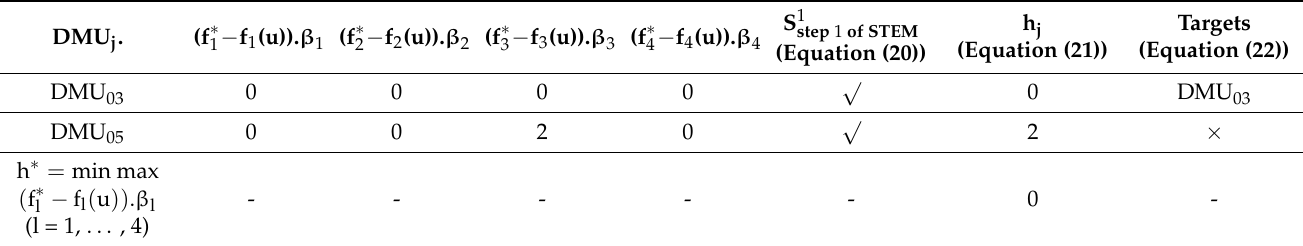
Table 11. Applying target finding stages 1–2 to solve step 1 of STEM (p = 1) for DMU 05 (the first case study). DMU j